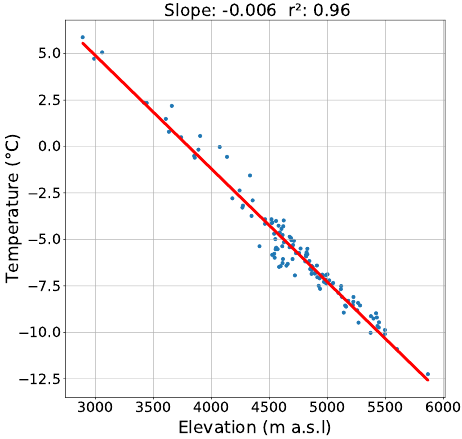
Figure A2. Scatterplot of ERA5-L air temperature at 2m and model elevations of the 121 ERA5-L grid cells around the location of Halji glacier. The temperatures are the long-term means of each grid cell from 1981 to